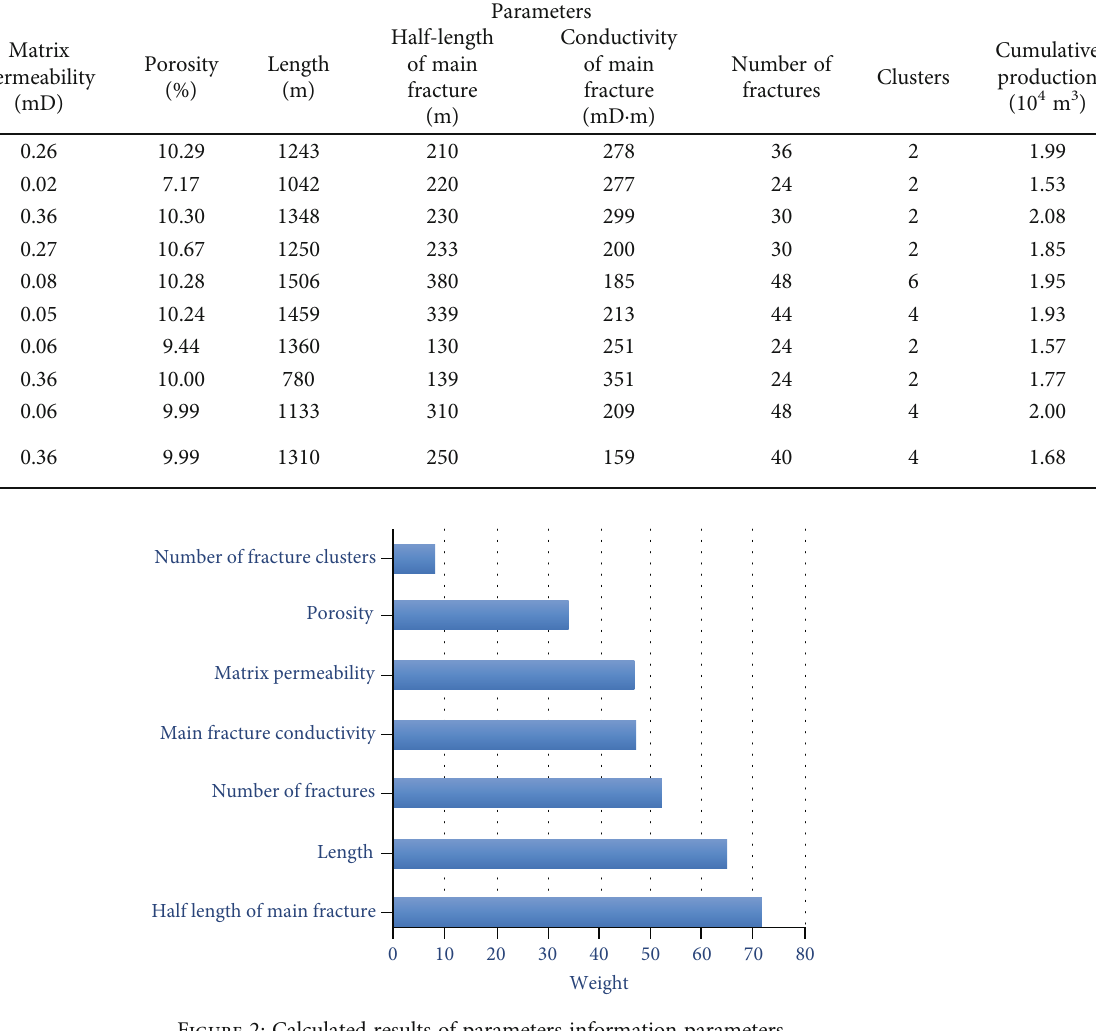
Figure 2: Calculated results of parameters information parameters.